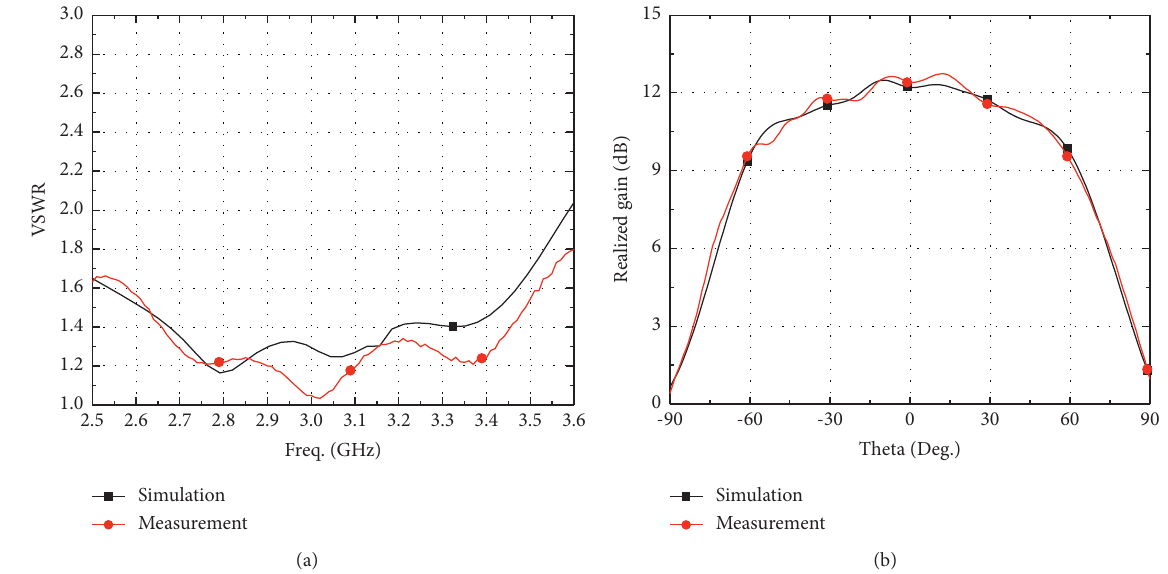
Figure 10: The results of the simulated and measured subarray. (a) VSWR. (b) Radiation patterns (3GHz).